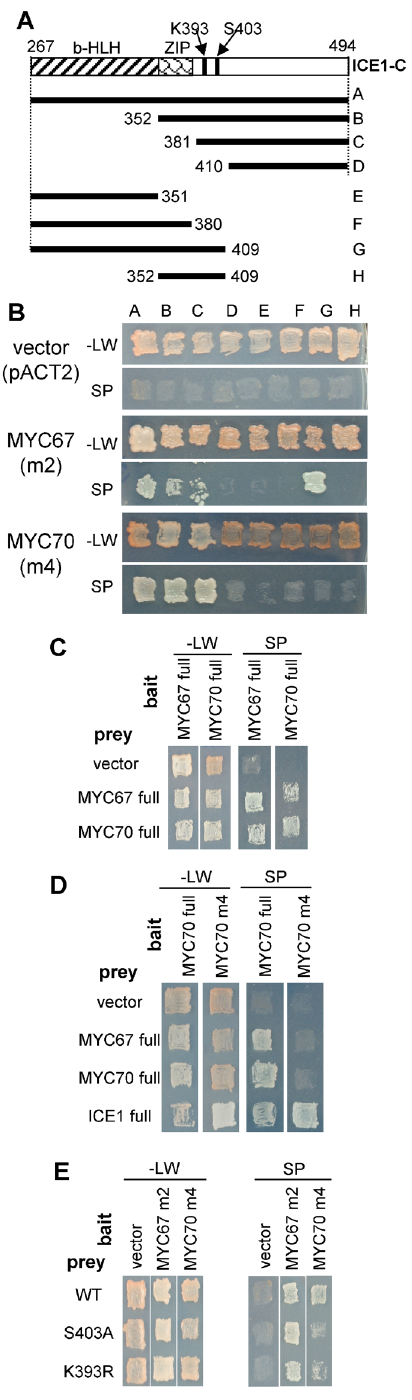
Figure 2. Interactions between ICE1, MYC67, and MYC70. ( A ) A schematic representation of the deletion constructs for ICE1. The indicated regions of ICE1 were cloned into the bait vector pGBKT7. ( B ) The interaction of ICE1 with MYC67 or MYC70 was assessed using the yeast 2-hybrid assay. The ICE1 bait plasmid was transformed with either pACT2 (vector control), pACT2-MYC67 m2 (amino acids 3–358), or pACT2-MYC70 m4 (amino acids 246–359). Yeast grown on SD media without leucine and tryptophan (upper, − LW) and on selection plates (lower, SP) are shown. ( C ) MYC67 and MYC70 form homodimers and interact with each other. Yeast strains containing full-length pGBKT7-MYC67 or pGBKT7-MYC70 as bait were transformed with pACT2 (vector control), full-length pACT2-MYC67 or full-length pACT2-MYC70 as prey. Yeast was incubated on − LW or on SP. ( D ) Only ICE1 was able to interact with the C-terminal region of MYC70 in the yeast 2-hybrid assay. MYC70 full was interacted with MYC67, MYC70, and ICE1, but MYC70 m4 was able to interact with ICE1. ( E ) The effect of ICE1 point mutations, S403A or K393R, on the interactions with MYC67 and